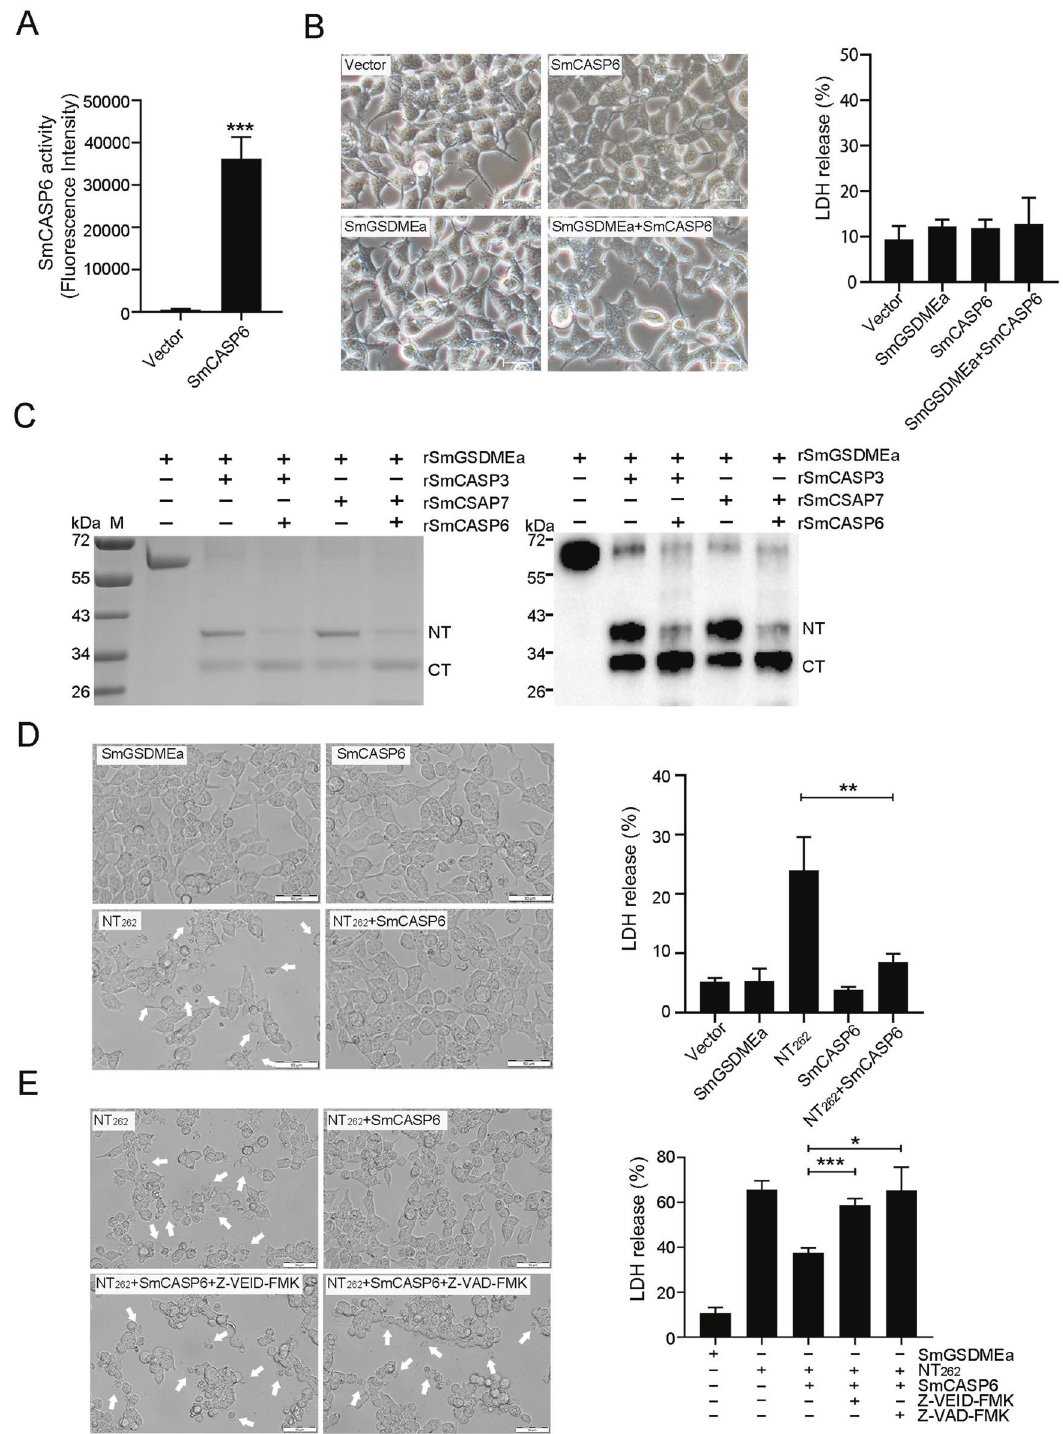
Fig. 6 SmCASP6 inhibits SmGSDMEa activation. A The enzymatic activity of SmCASP6 in SmCASP6-transfected HKE293T cells was assessed. B Bright- fi eld images of HKE293T cells transfected with the backbone vector or the vector expressing SmGSDMEa, SmCASP6, or SmGSDMEa plus SmCASP6 (left panel). Scale bar, 20 μ m. LDH released from the transfected cells is shown on the right. C rSmGSDMEa was pre-incubated with rSmCASP3 or 7 and then treated with rSmCASP6 for 3 h. The products were subjected to SDS-PAGE (left) and immunoblot with anti-His tag antibody (right). D Bright- fi eld images of HKE293T cells transfected with the backbone vector or the vector expressing SmGSDMEa, SmGSDMEa-NT 262 , SmCASP6, or SmGSDMEa-NT 262 plus SmCASP6 (left). White arrows indicate pyroptotic cells. Scale bars, 50 μ m. LDH released from the transfected cells is shown on the right. E HKE293T cells expressing SmGSDMEa-NT 262 or SmGSDMEa-NT 262 plus SmCASP6 in the presence or absence of Z-VAD-FMK and Z-VEID-FMK were subjected to microscopy (left) or LDH measurement (right). White arrows indicate pyroptotic cells. Scale bar, 50 μ m. For panels A , B , D , and E , data are shown as means ± SD, n = 3. *** P < 0.001; ** P < 0.01; * P < 0.05.